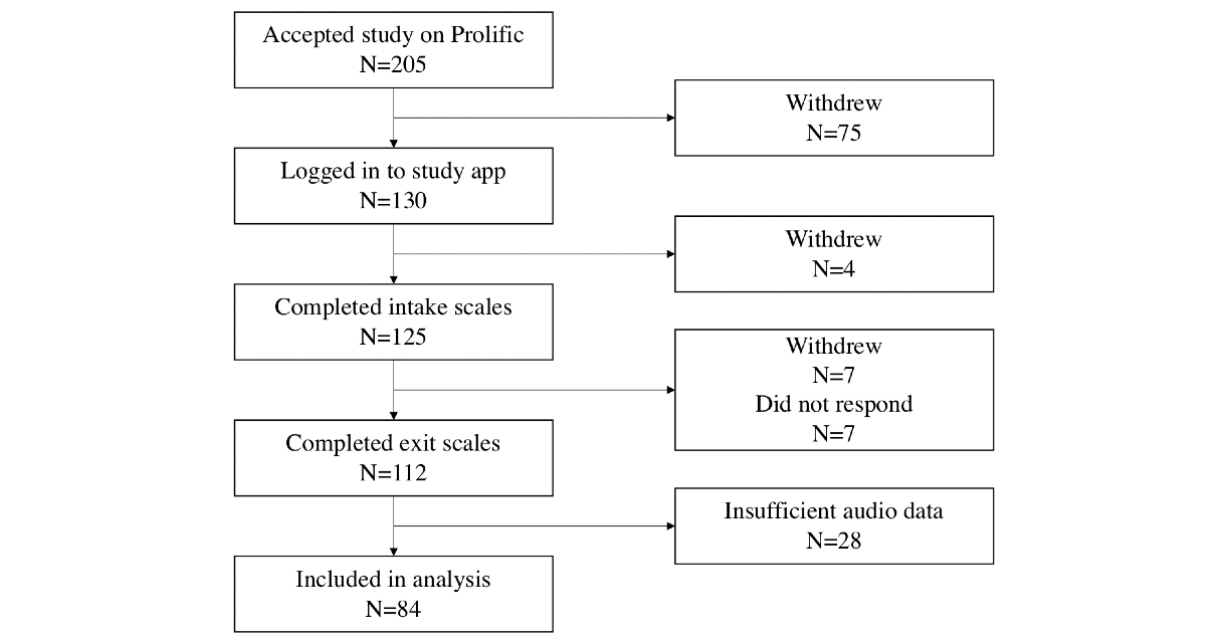
Figure 2. Flow chart of study